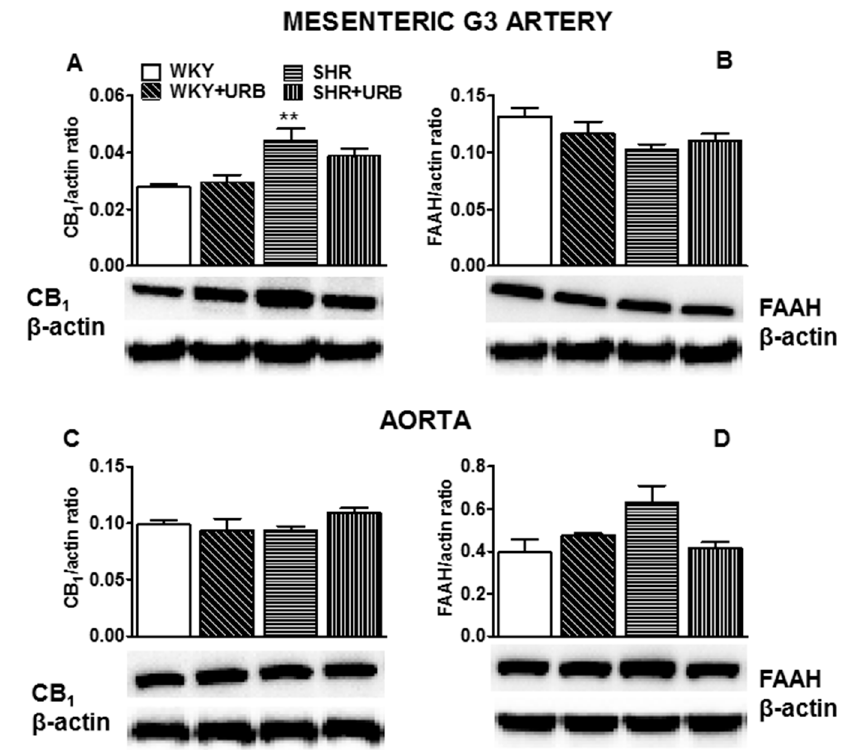
Figure 6. Western blots of CB 1 ( A , C ) and fatty acid amide hydrolase (FAAH; B , D ) protein in the mesenteric G3 arteries ( A , B ) and aortas ( C , D ) of normotensive rats—control (WKY) and URB597- treated (WKY + URB)—or hypertensive rats—SHR and URB597-treated (SHR + URB). URB597 at 1 mg/kg or its vehicle was injected intraperitoneally every 12 h for 14 days. On the bottom of the panel, representative Western blots for CB 1 , FAAH, and β -actin (which served as the loading control) are shown. Mean ± SEM of 5–6 rats; ** p < 0.01 compared to the control group (* WKY).